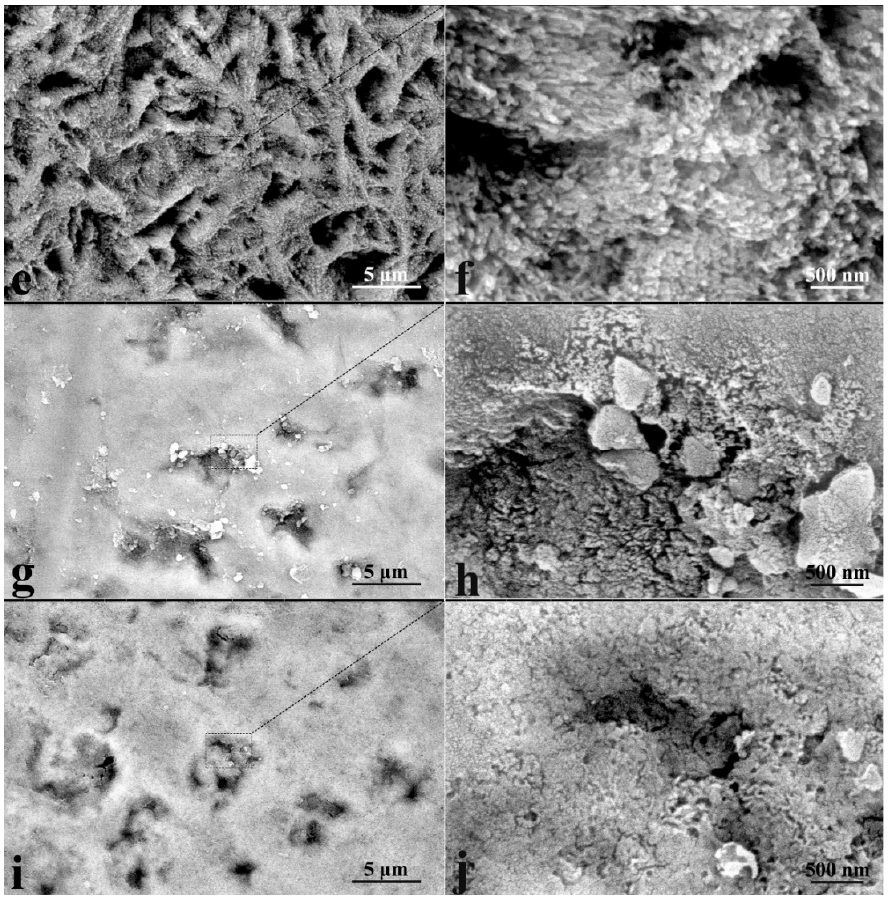
Figure 5. FESEM images of typical surface areas of mineralized tooth tissue samples with two magnifications (×13000 on the left and ×50000 on the right): ( a , b ) healthy tooth enamel without treatment (sample N1); ( c , d ) without pretreatment and with subsequent mineralization (sample N2); ( e , f ) after surface pretreatment with H 3 PO 4 and subsequent mineralization (sample N3); ( g , h ) after surface pretreatment with Ca(OH) 2 and subsequent mineralization (sample N4); ( i , j ) after surface pretreatment with Ca(OH) 2 and amino acid booster, with subsequent mineralization (sample N5).